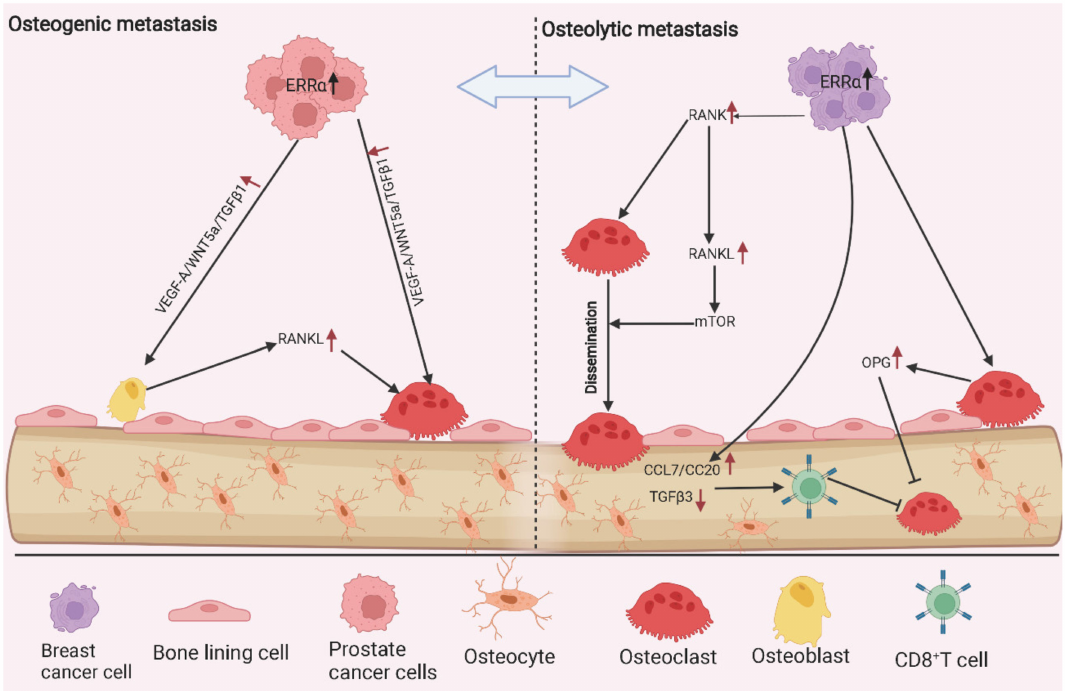
Figure 3. The functional role of ERR α in osteogenic and osteolytic metastases. Both osteogenic and osteolytic metastases are involved in the interactions among tumor cells, osteoblasts and osteoclasts, osteogenic and osteolytic metastases can reciprocally transit. In the osteogenic lesions, ERR α overex- pression in prostate cancer cells directly or indirectly modulate bone re-modeling by boosting the expression of metastasis factors (VEGF-A, TGF β 1, WNT5A). The interactive modulation between osteoblasts and osteoclasts generates a tumor-friendly environment to facilitate tumor anchoring and growth. In the breast cancer, ERR α promotes the cell growth in situ but inhibits the prolifera- (OPN-mediated growth repression and cytokines-induced immune activation). Moreover, ERR α